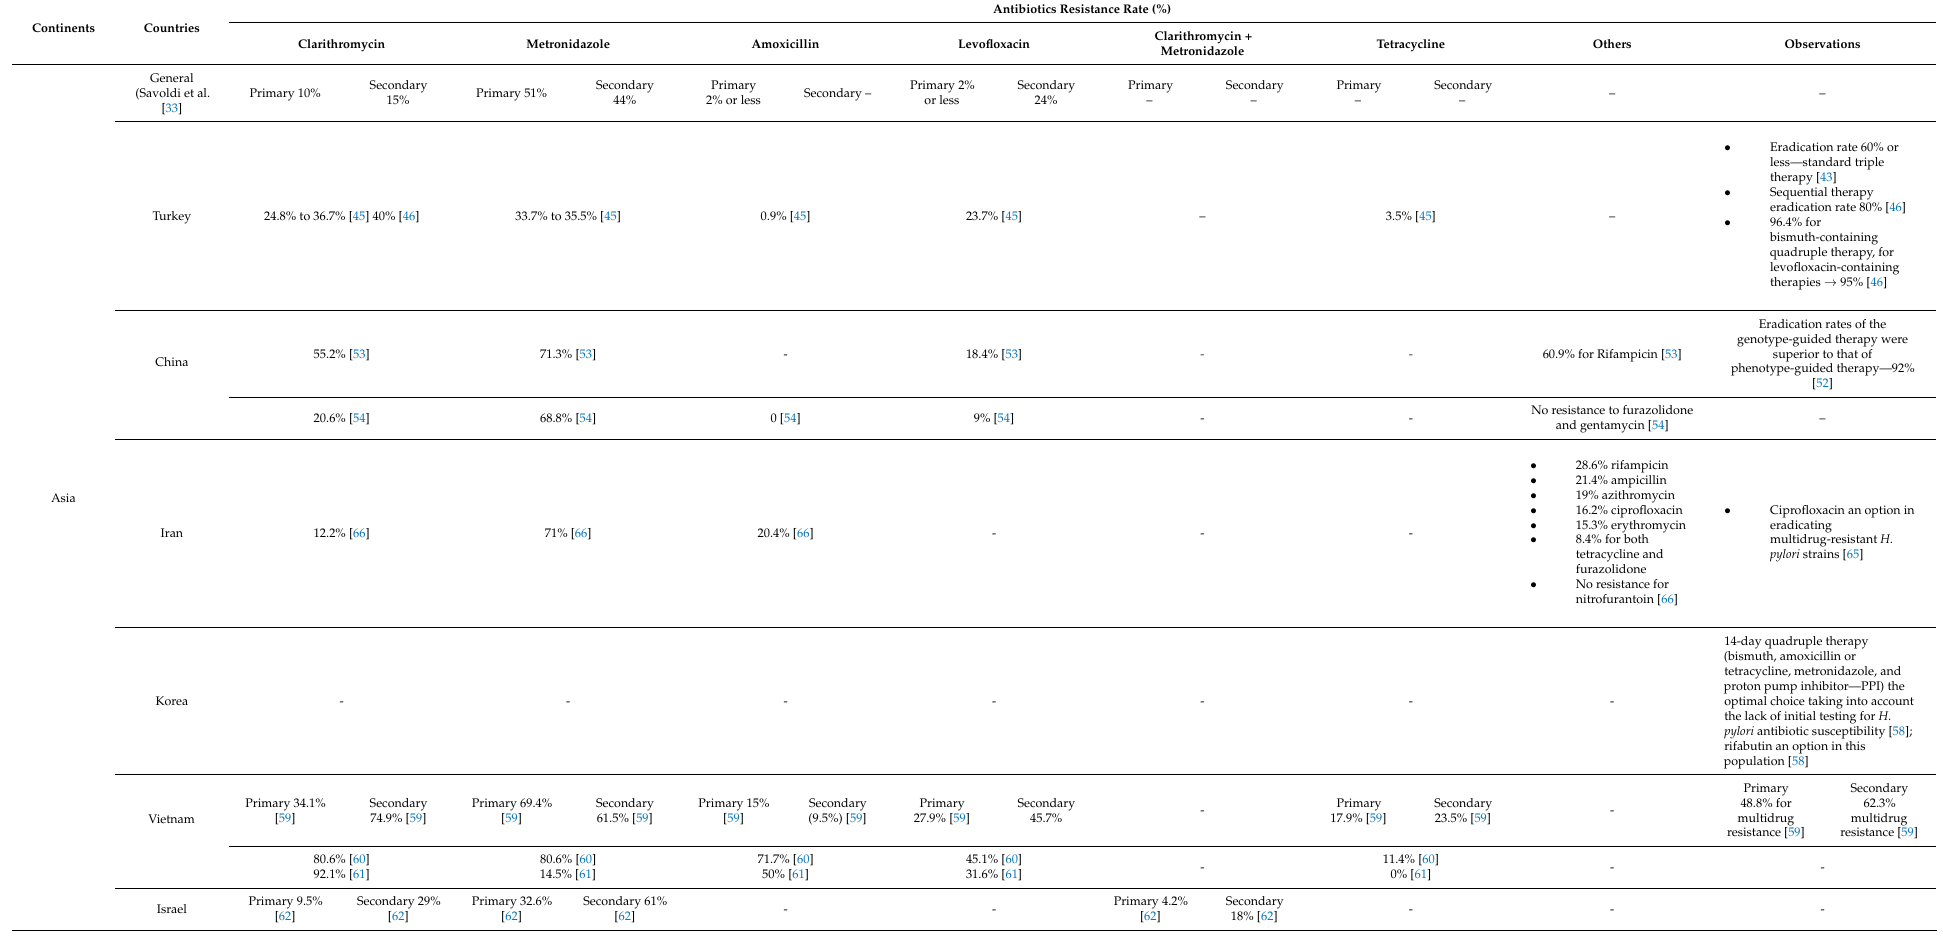
Table 1. H. pylori antimicrobial resistance among